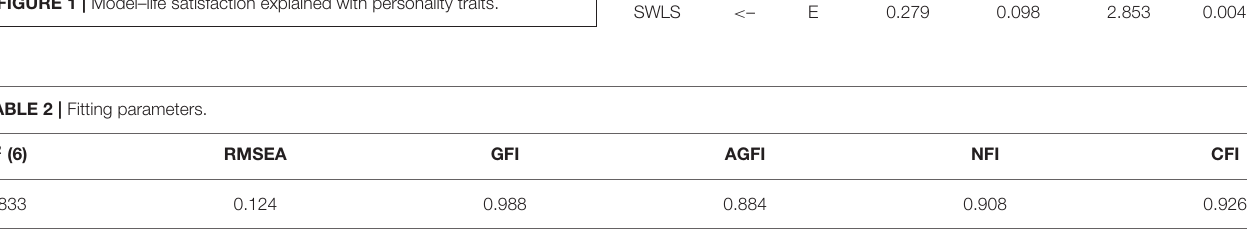
FIGURE 1 | Model–life satisfaction explained with personality traits.